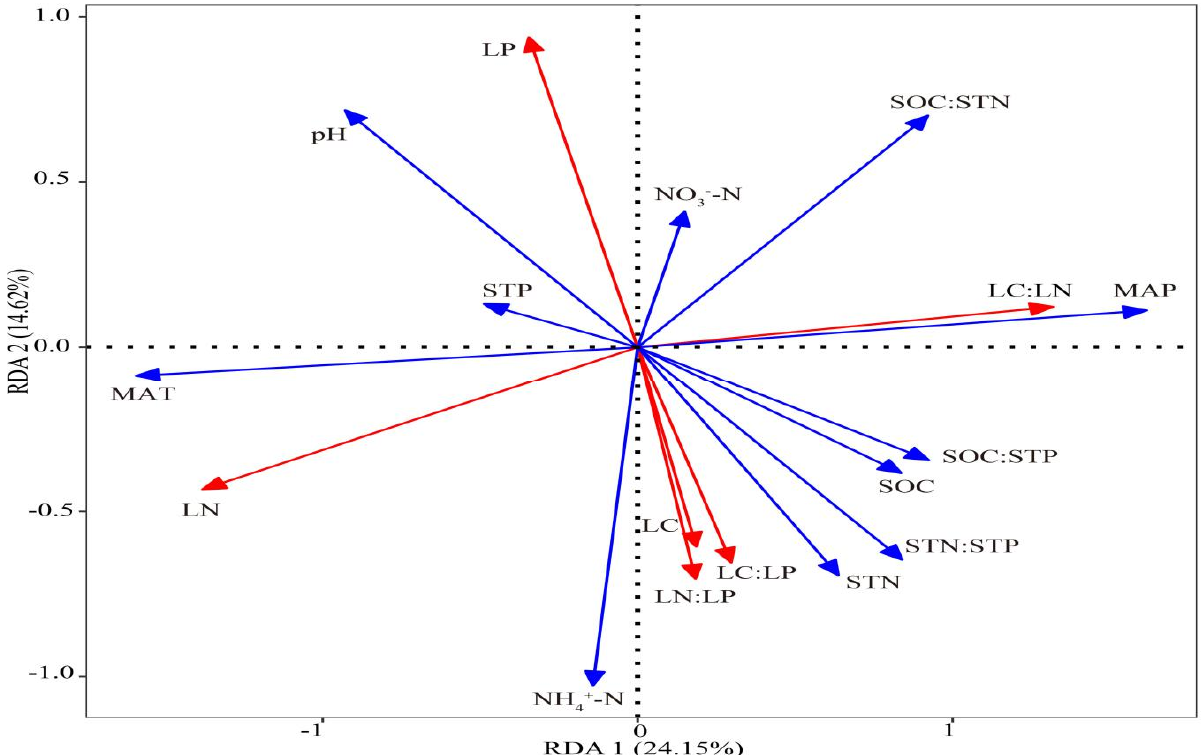
Figure 2. P. crassifolia LC ( A ), LN ( B ), and LP ( C ) and LC:LN ( D ), LC:LP ( E ), and LN:LP ( F ) ratios at different elevations. LC = leaf C concentration; LN = leaf N concentration, LP = leaf P concentration. For individual plots, non-matching low- ercase letters (e.g., a, b, …) indicate a significant difference in leaf stoichiometry between elevations.